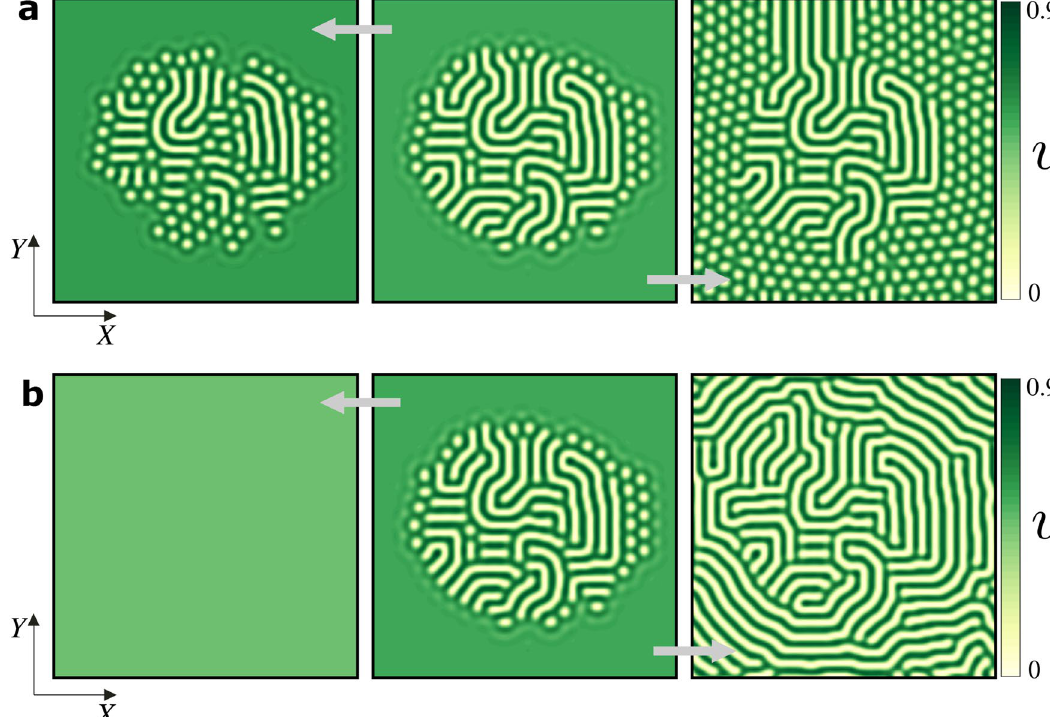
Figure 6. Deppining transitions of a localised labyrinth state ( η = 0.0102 ) in a non-variational Swift– Hohenberg model. This state is shown in the middle panel of ( a ) and ( b ). The localised pattern destabilize when crossing the pinning region boundaries when varying slowly ( a ) or abruptly ( b ) the aridity parameter. In the first case ( a ), when decreasing η the localized labyrinth loses its internal structure due to shrinking of stripes (left panel, η = 0.007 ), and when increasing η some stripes begin to grow at the interface of the localized labyrinth and a hexagon pattern starts to invade the uniform cover (right panel, η = 0.016 ) . In the second case ( b ), when decreasing η all the stripes and patches of sparse vegetation disappear in favor of a uniform vegetated cover (left panel, η = − 0.03 ), and when increasing η the vegetated cover becomes unstable and stripes emerge. This process transform the localised labyrinth into an extended one (right panel, η = 0.05 ). The other parameters are provided in the "Methods" section. From numerical simulations, the figure was created using Inkscape 1.0 (https:// inksc ape. org/ relea se/ inksc ape-1.